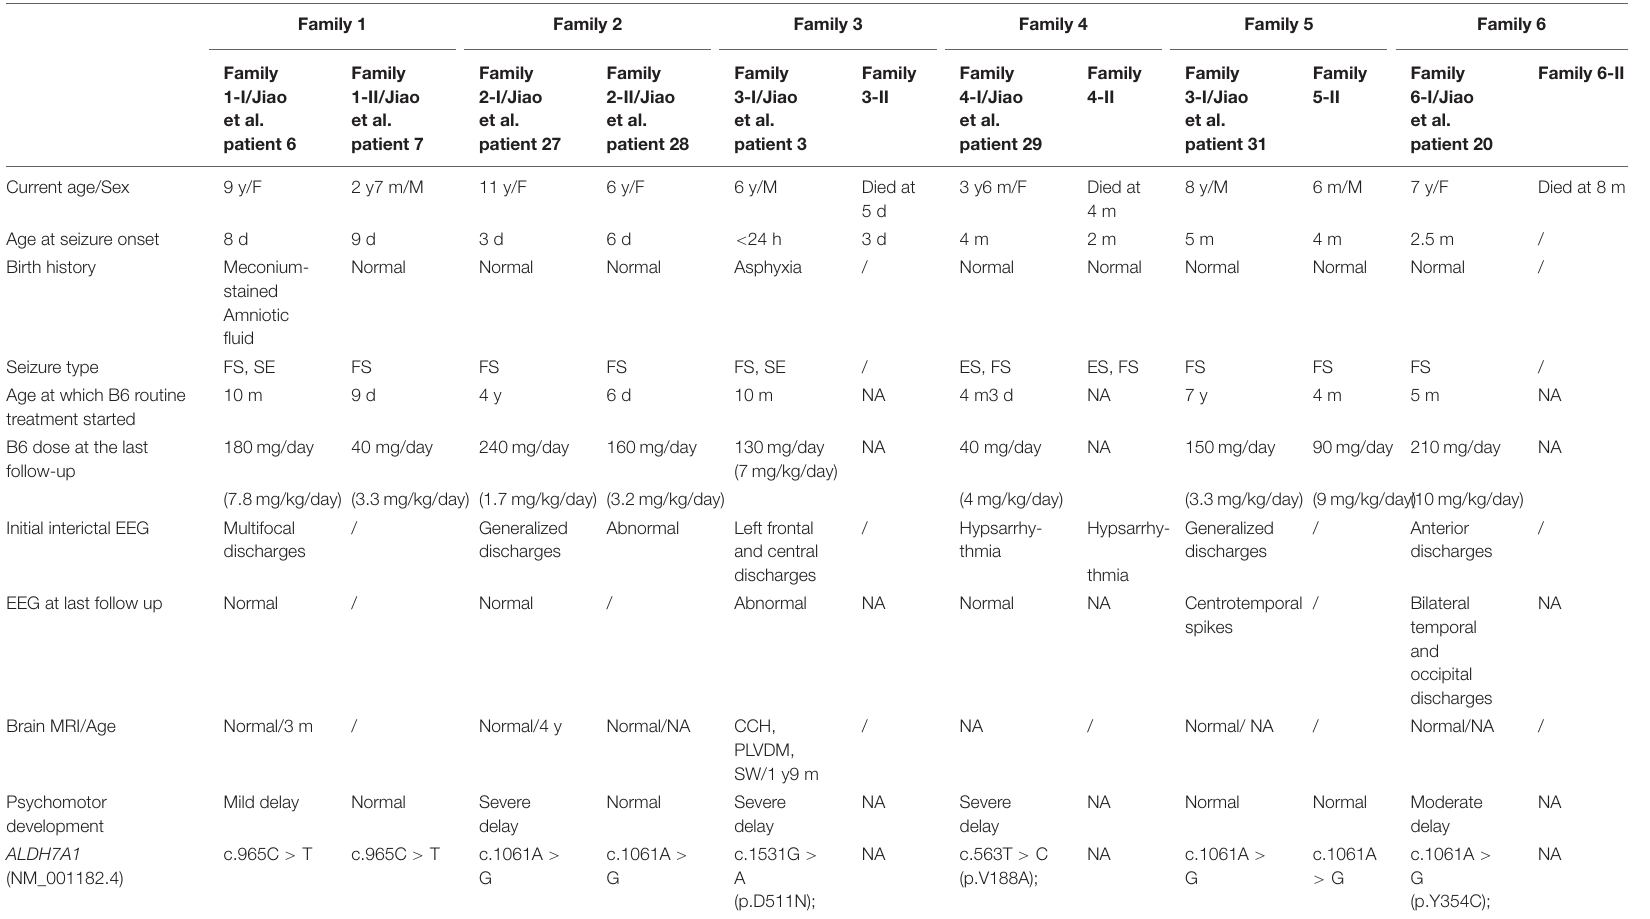
TABLE 1 | Genetic and clinical findings of the affected patients in six